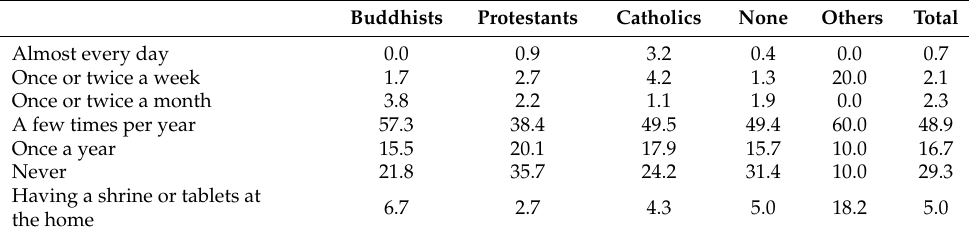
Table 8. Conducting ancestral rites at home and having a shrine or tablets (%), 2016